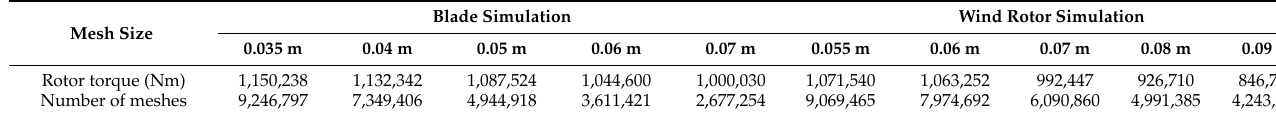
Table 4. Results of mesh sensitivity analysis.